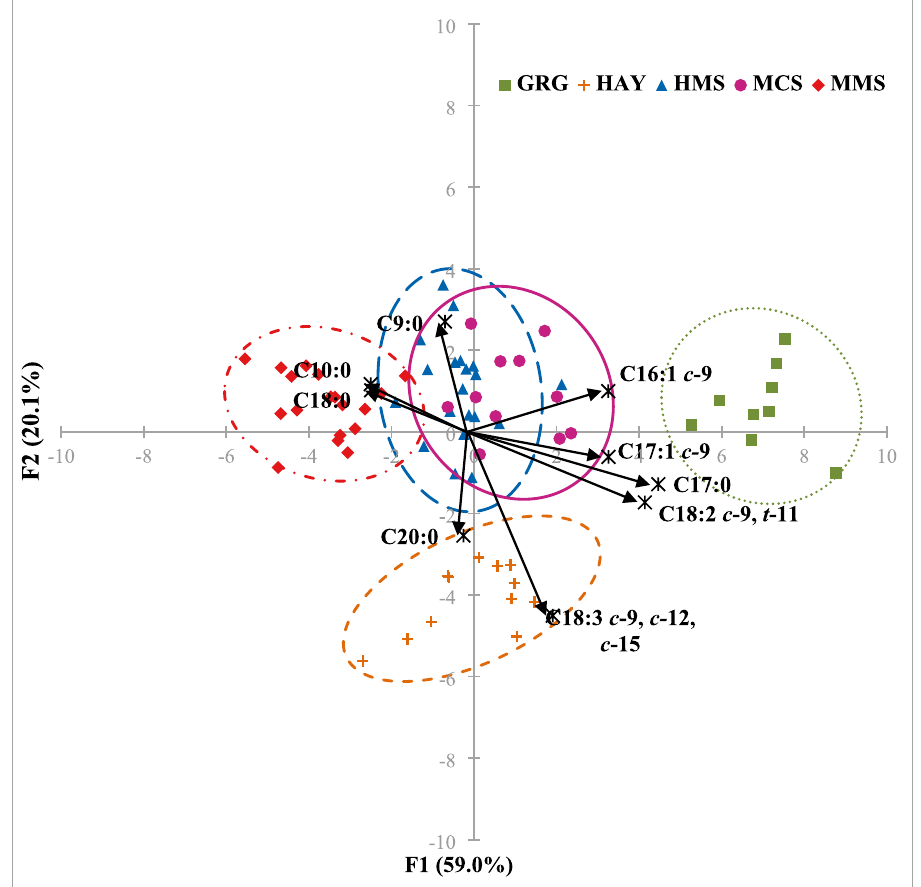
Figure 1. FDA scatterplot of the milk samples according to the five feeding groups based on the fatty acid profiles. The main function F1 (along x-axis) and F2 (along y-axis) accounted for 59.0% and 20.1% of the total variance, respectively. The 0.95 confidence ellipses are drawn around each centroid of groupings. High maize silage (HMS): blue dotted line and blue upward triangles; medium maize silage (MMS): red dotted-pointed line and red diamond symbols; mixed crop silages (MCS): solid purple line and purple closed circles; grass and lucerne hays (HAY): orange dotted line and orange plus symbols; green grass (GRG): green pointed line and green closed squares. The black arrows indicate the most significant ( p < 0.05) discriminative FA that had correlation coefficient values higher than 0.20 with at least either F1 or F2 (for graphic purposes these significant correlations coefficients were multiplied 10 times according to the maximum value of F1 and